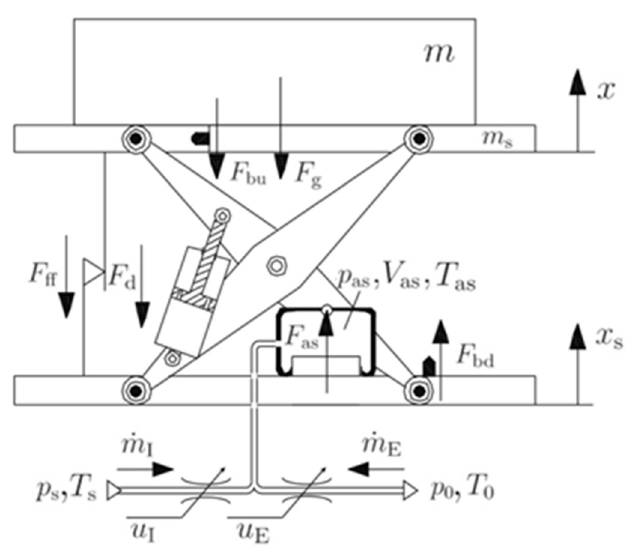
Appl. Sci. 2019 , 9 , x FOR PEER REVIEW Figure 5. A seating system with an active pneumatic spring suspension [52]. Figure 5. A seating system with an active pneumatic spring suspension [52].